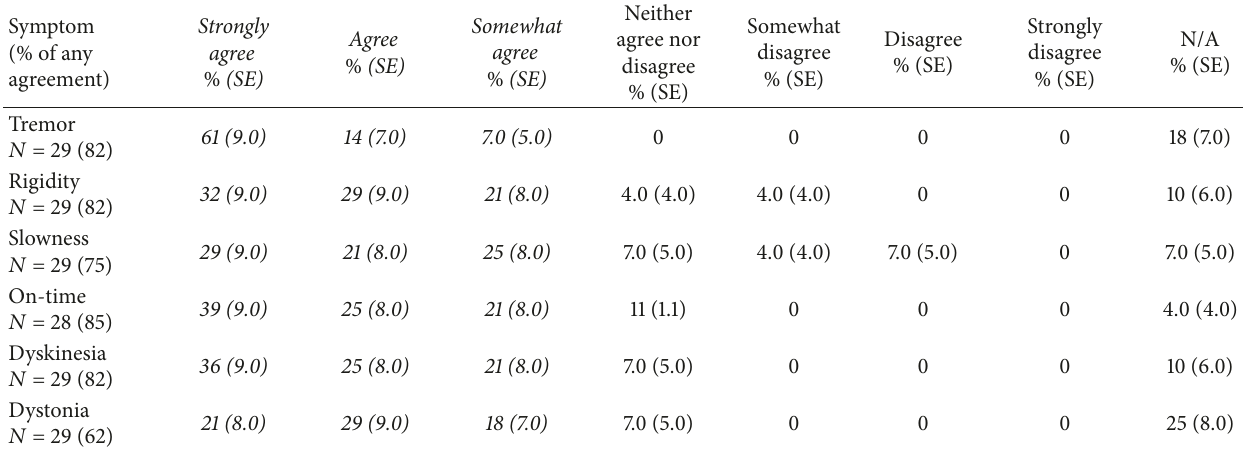
Table 2: Percentage of patients having their motor expectations met after DBS